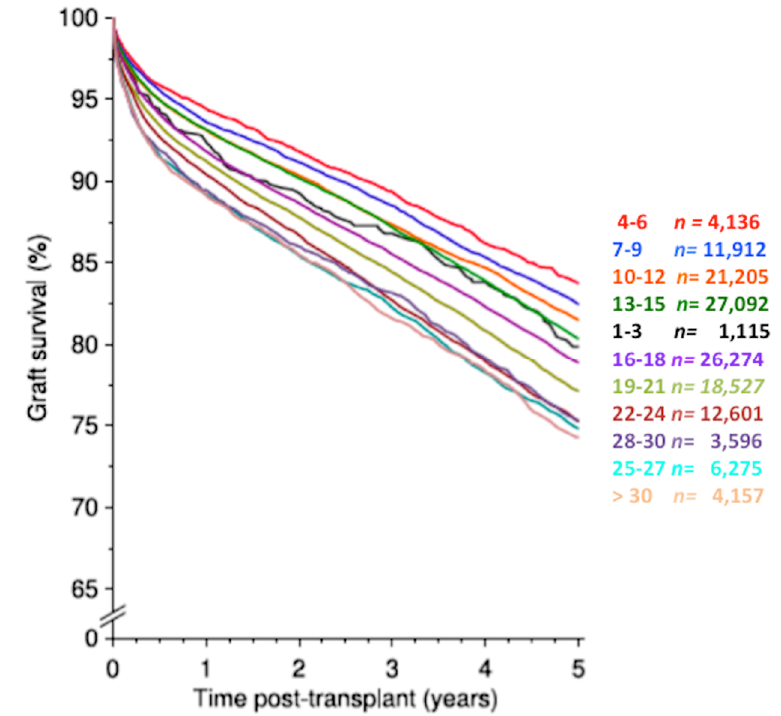
Figure 5. Influence of cold ischemia time on five-year graft survival in adult recipients of deceased-donor kidney transplantation. The impact of cold ischemia time was more pronounced among grafts with a cold ischemia time > 18 h (obtained from CTS newsletter 4 / 2019, accessed 20 January 2020, www.ctstransplant.org).